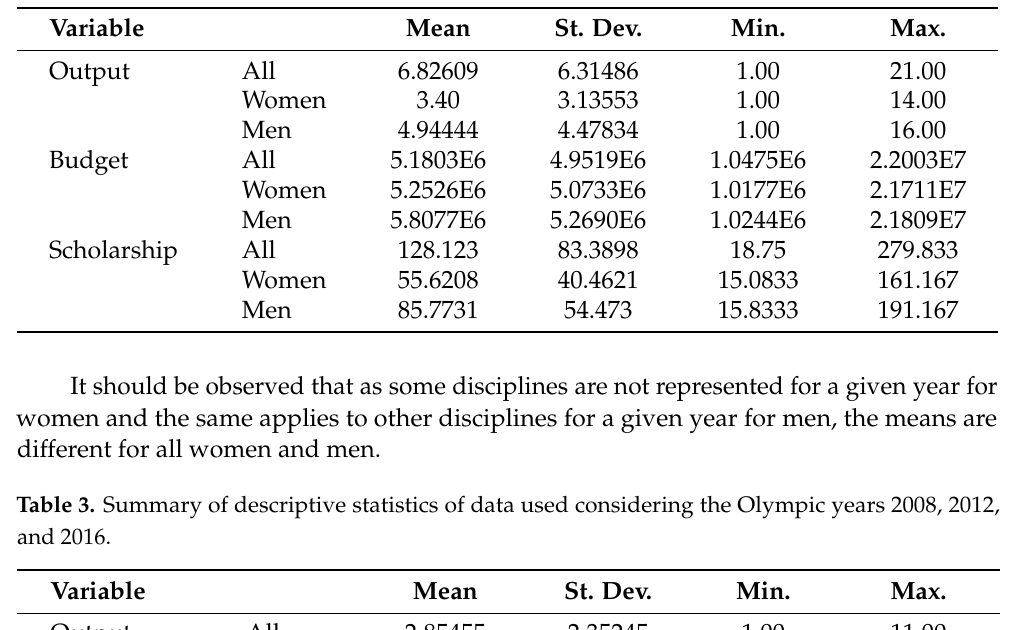
Table 2. Summary of descriptive statistics of data used considering the different disciplines during the period 2005–2016.